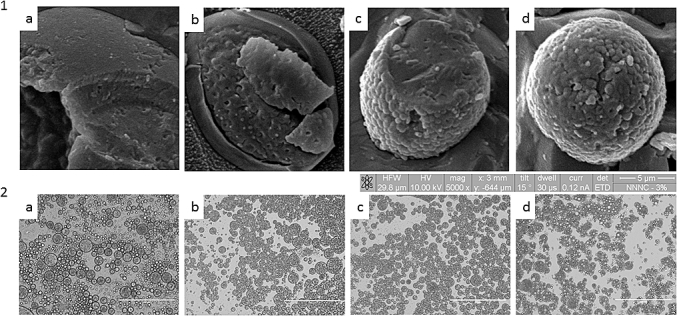
Cryo-SEM (1) and light microscopy (2) images of an oil droplet of the w1/o/w2 emulsion stabilised with unmodified - starch (a) and increasing level of OSA modification: 1.5% (b), 2% (c) and 3% (d). The scale bar in each light micrograph corresponds to 200 μm.